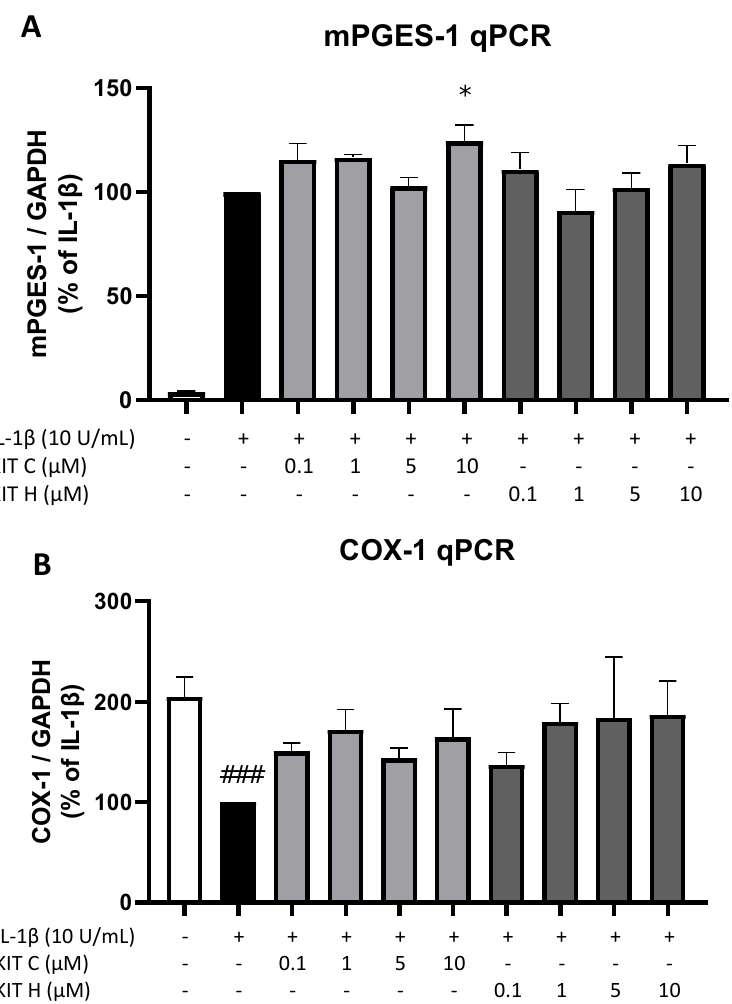
Figure 6. Effects of KIT C (light grey bars) and KIT H (dark grey bars) on mPGES-1 ( A ) and COX-1 mRNA expression ( B ) in IL-1 β -stimulated SK-N-SH cells. Cells were stimulated as described under material and methods. After 4 h of stimulation, RNA was isolated and mRNA levels of the shown target genes were measured using qPCR. Values are presented as the mean ± SEM of at least three independent experiments. Statistical analysis was performed using one-way ANOVA with Dunnett’s post hoc tests with * p < 0.05 and ### p < 0.001 compared to IL-1 β ( A ) or to untreated cells ( B ). Besides the AA/PGE 2 pathway, the effects of KIT C (light grey bars) and KIT H (dark grey bars) on IL-1 β -induced IL-6 as pro-inflammatory and IL-10 as anti-inflammatory cytokines were investigated (Figure 7). Stimulation with IL-1 β for 24 h potently induced IL- 6 release in SK-N-SH cells but neither KIT C nor KIT H nor O-1602 affected IL-6 production (Figure 7A). The GPR55 antagonist ML 193, however, significantly reduced IL-1 β and increased IL-6 release by about 60% in IL-1 β -treated SK-N-SH cells. IL-1 β reliably induced IL-10 mRNA expression in SK-N-SH cells as shown by qPCR, and KIT C as well as KIT H both enhanced IL-1 β -stimulated IL-10 mRNA levels in concen- trations of 10 µ M compared to IL-1 β the positive control (Figure